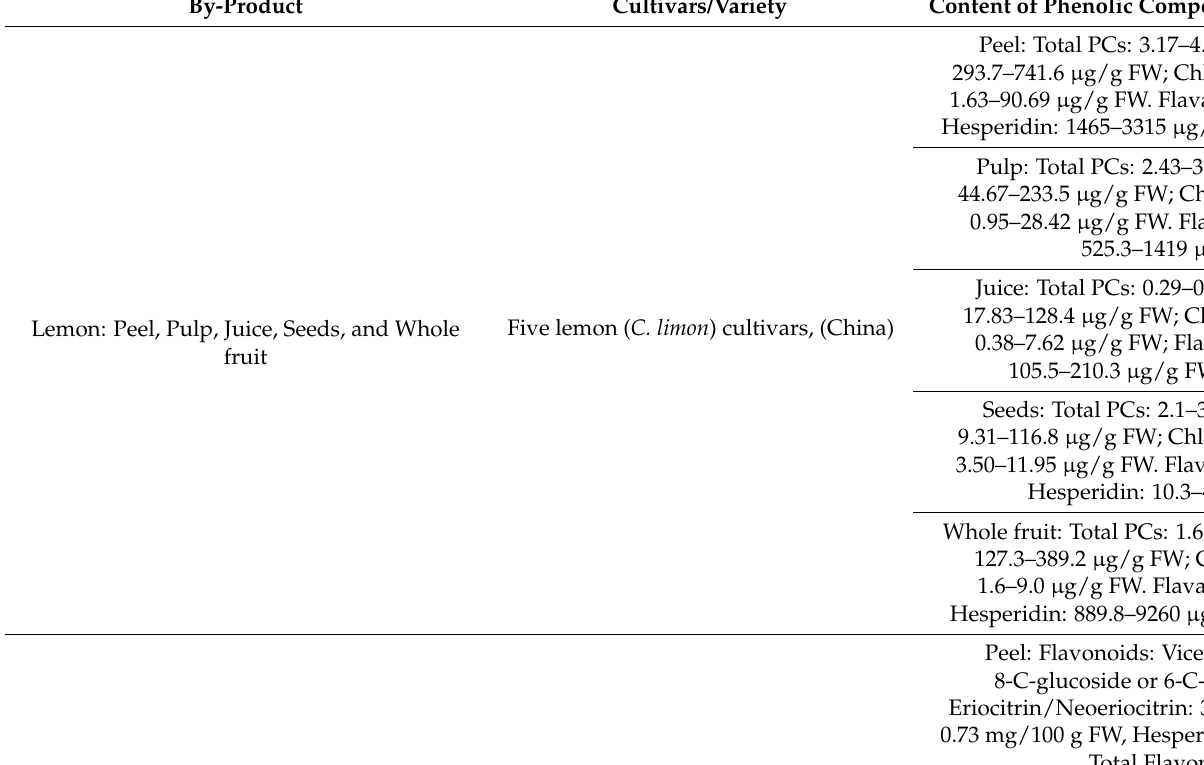
Table 3. Major phenolic compounds (PCs) present in lemon by-products.